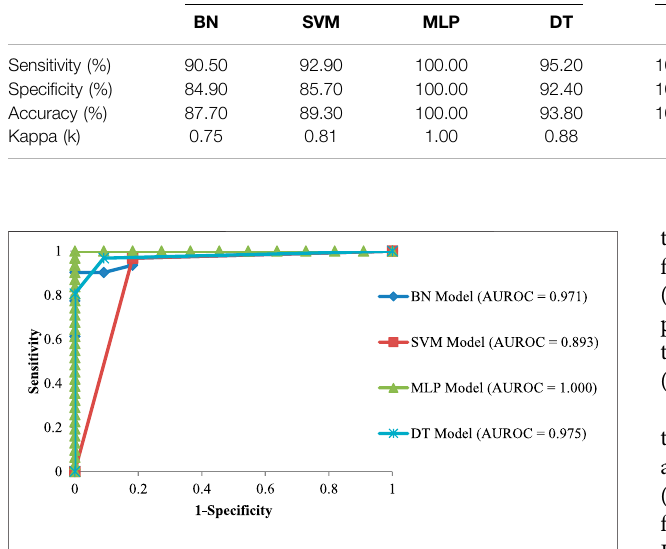
TABLE 5 | ML technique evaluation in training dataset using different performance measures. Parameters